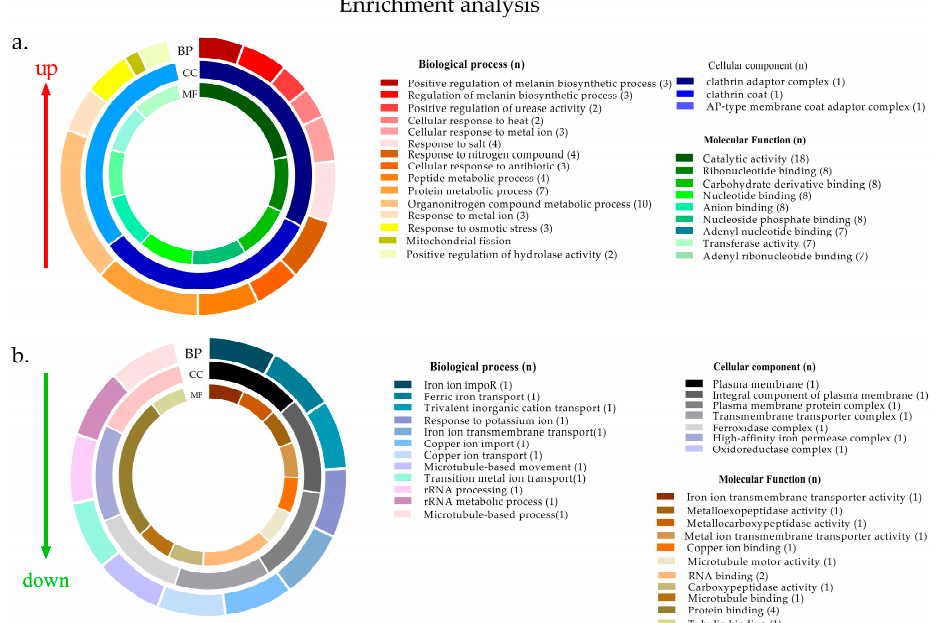
Figure 6. Gene ontology (GO) analysis of the proteins considered differentially abundant after exposure to metals using ( a ) up-regulated ( b ) down-regulated proteins. Number of genes found in each term